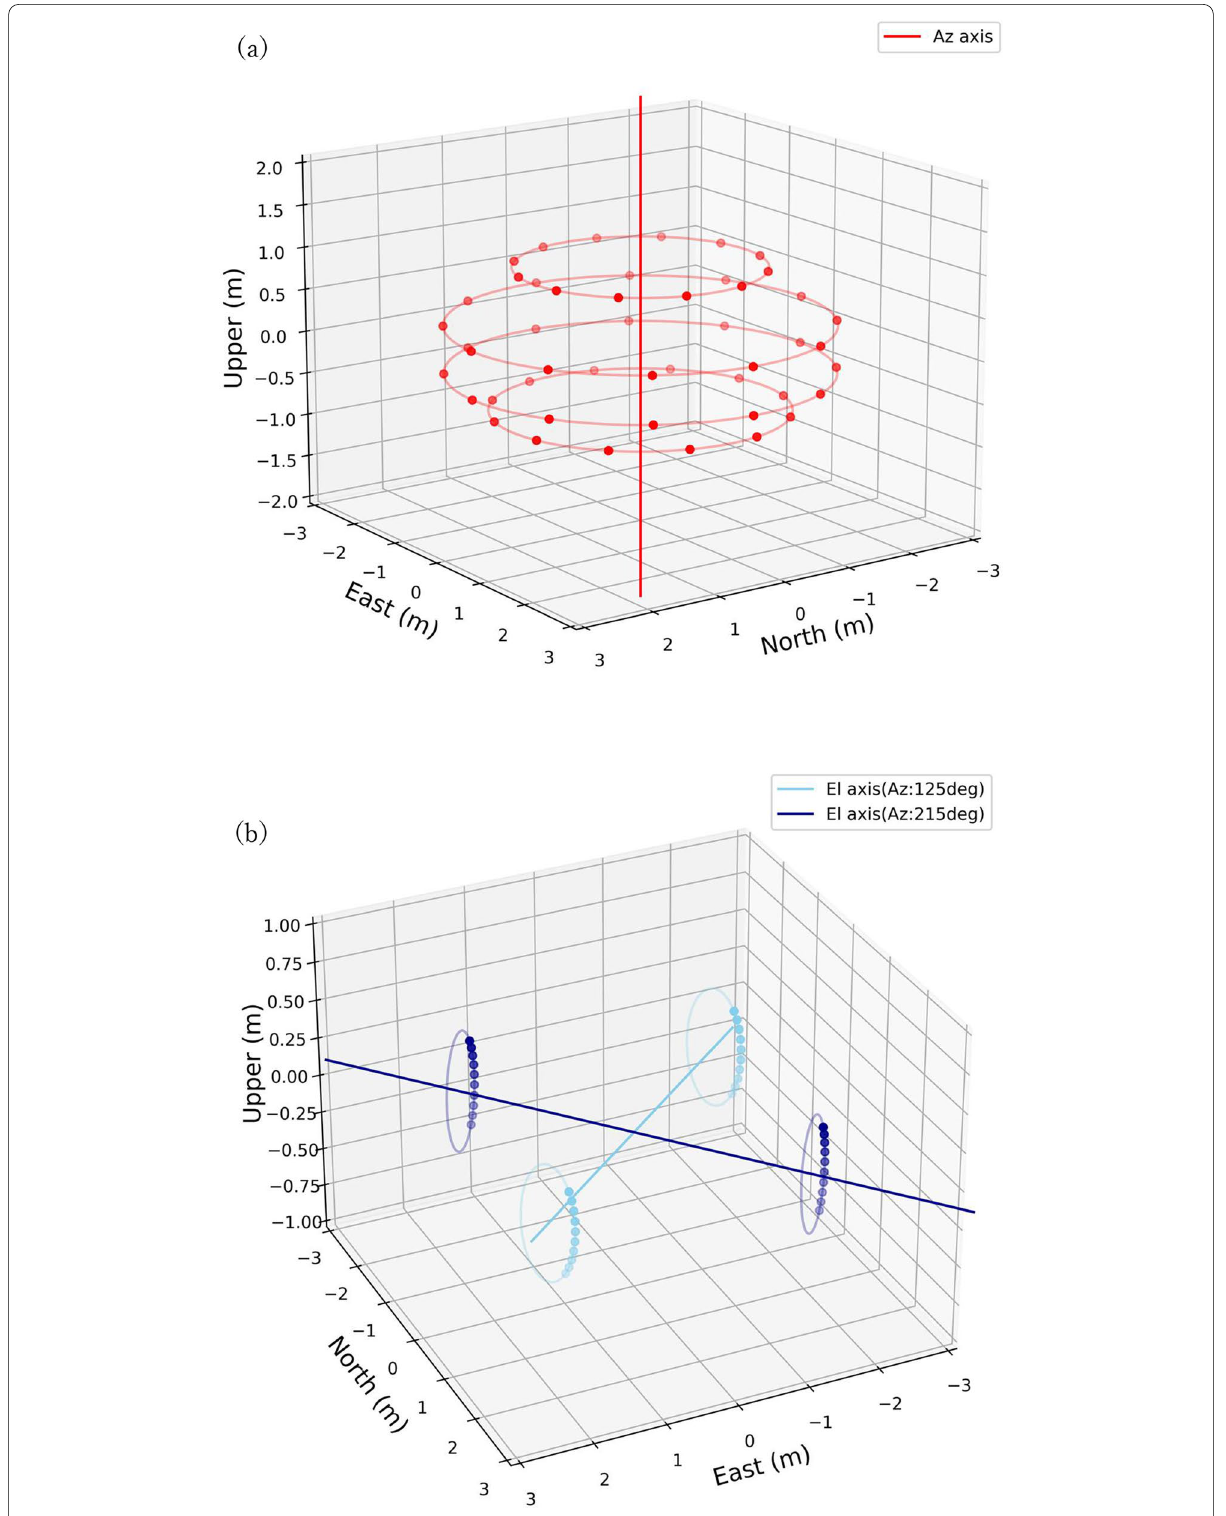
Fig. 8 (See legend on previous